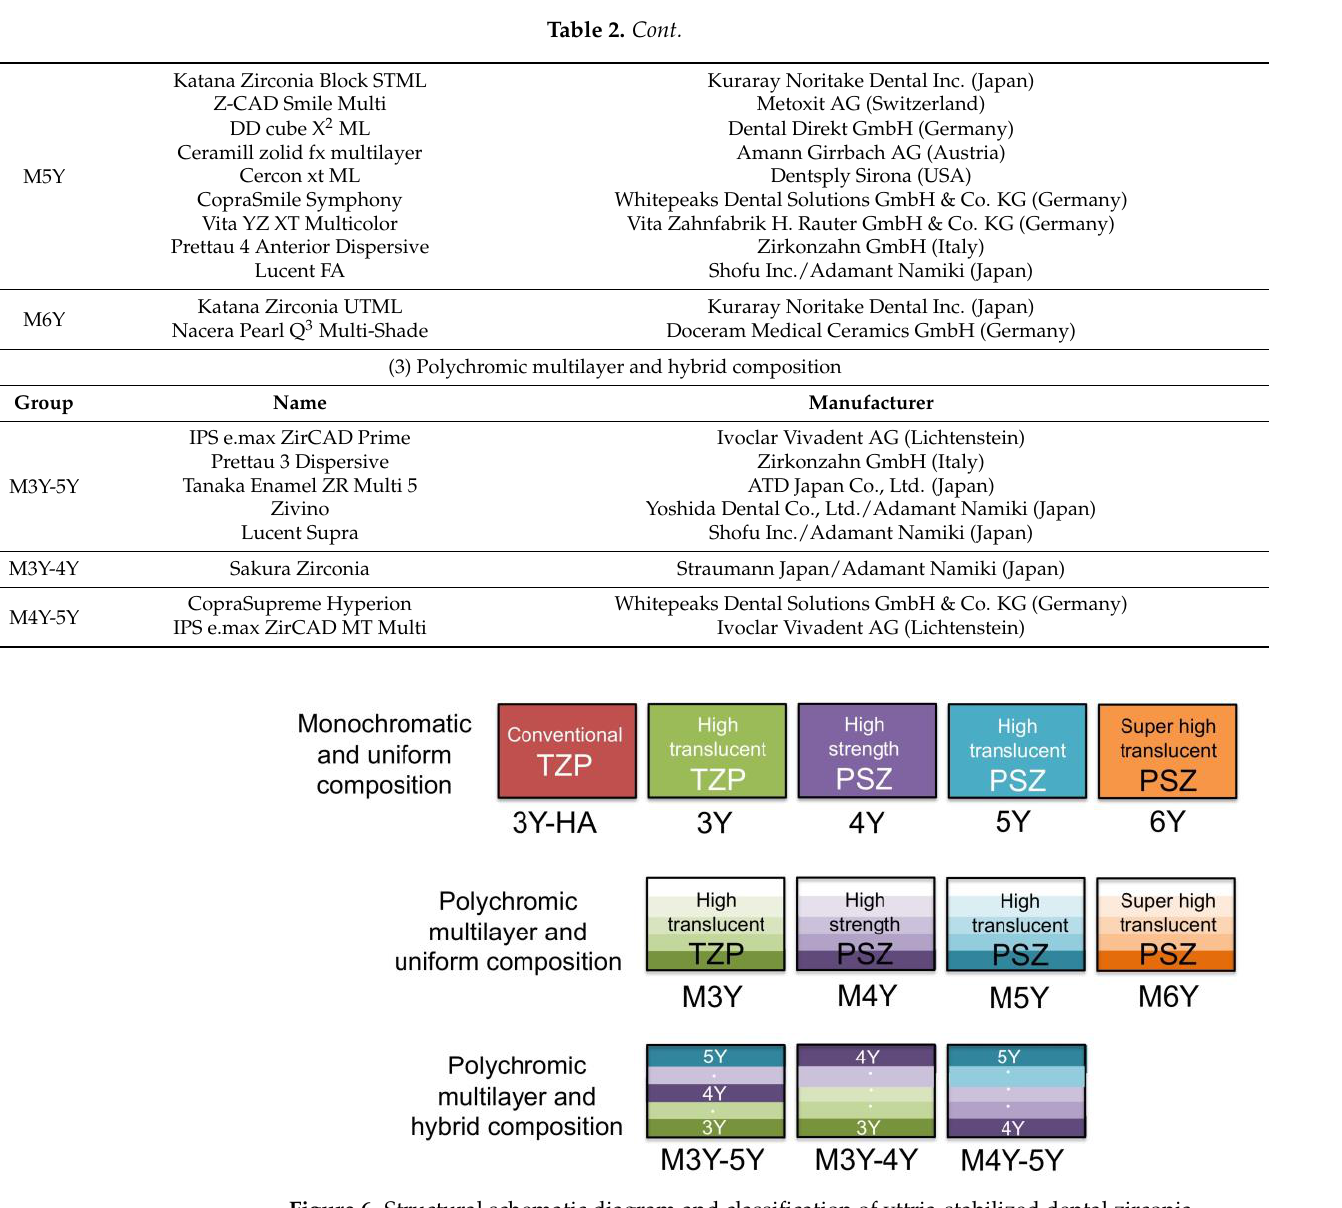
Figure 7. Relation between flexural strength and translucency of classified dental zirconia. Therefore, the higher the translucency, the lower the strength. This contradictory re- lationship must be fully considered when applying zirconia to dental restorations. In other words, 3Y, which has high strength but low translucency, can be applied to long-span bridges, but is not suitable for anterior tooth crowns. On the other hand, 5Y and M5Y, which have low strength but high translucency, cannot be applied to long-span bridges, but can be applied to anterior tooth crowns and veneers. In the case of the polychromatic and hybrid composition multilayer type, such as M3Y-5Y, the application case of 5Y hav- ing low strength is dominant. On the other hand, both 4Y and M4Y are applicable to cases of all sites in sufficient terms of strength and translucency.